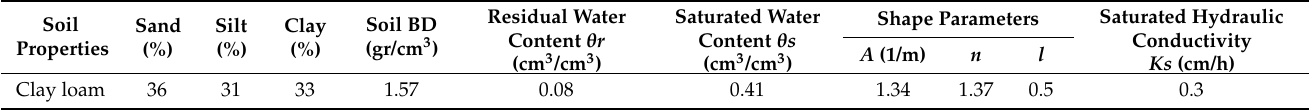
Figure 3. Planar view of the input, output, return branches, and the emitter positions in the buried part of the three drip laterals at the 0.2 m depth in the soil box.